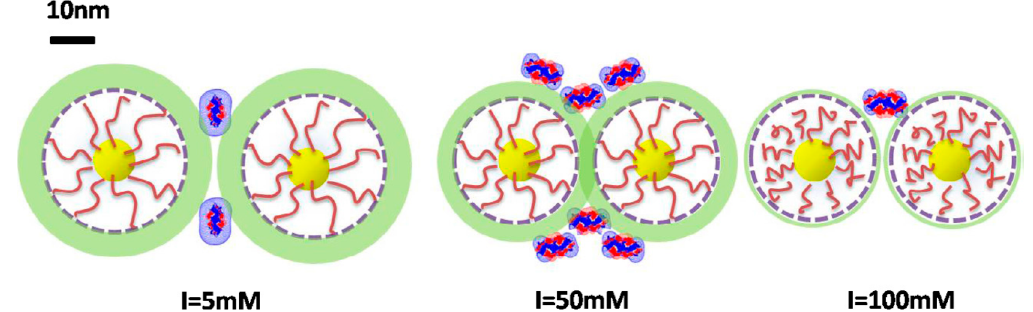
Figure 6. Schematic illustration of BLG/Fe 3 O 4 –PMATAC nanoparticles interaction at various ionic strengths. Green shading area represents a potential contour. The scale bar was added to define 10 nm length. Figure 6 was taken from the work of [34].